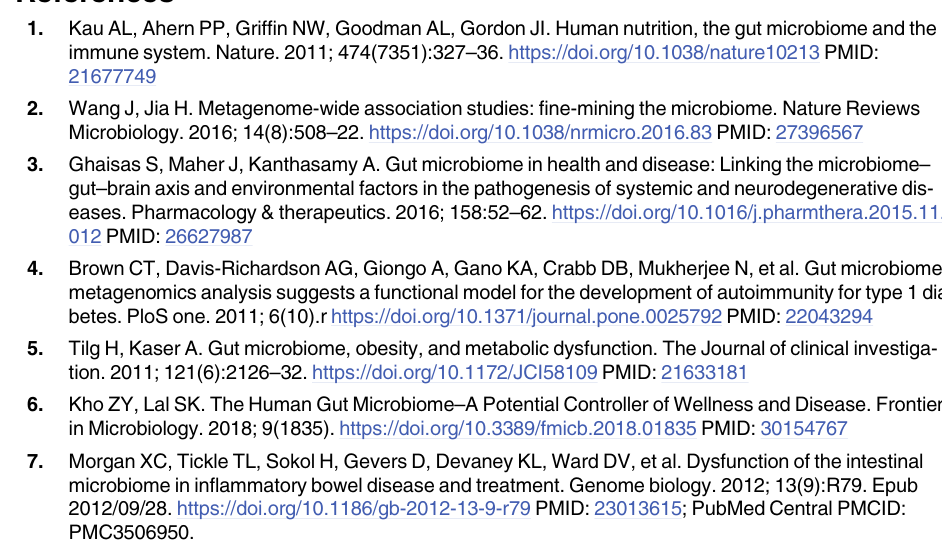
S3 Table. Evaluation of the IBD (External) data. Benchmarking results using